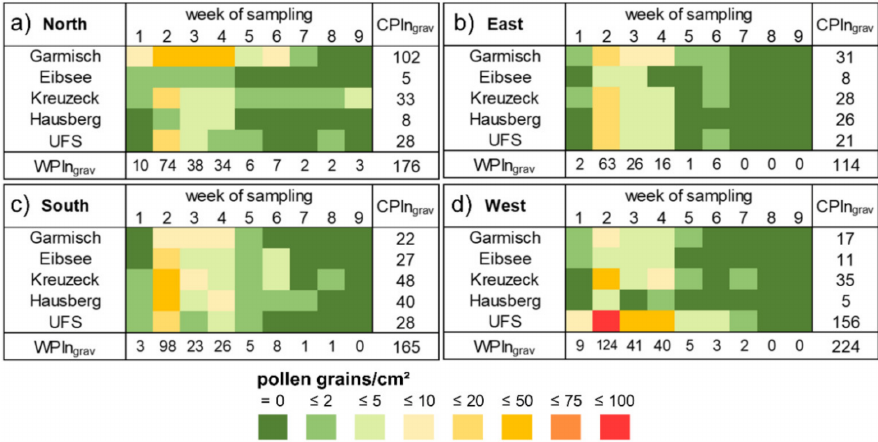
Figure 7. Weekly pollen (pollen grains/cm 2 ) transported to the vertical orientated slides in the ( a ) north, ( b ) east, ( c ) south and ( d ) west between 1 April and 3